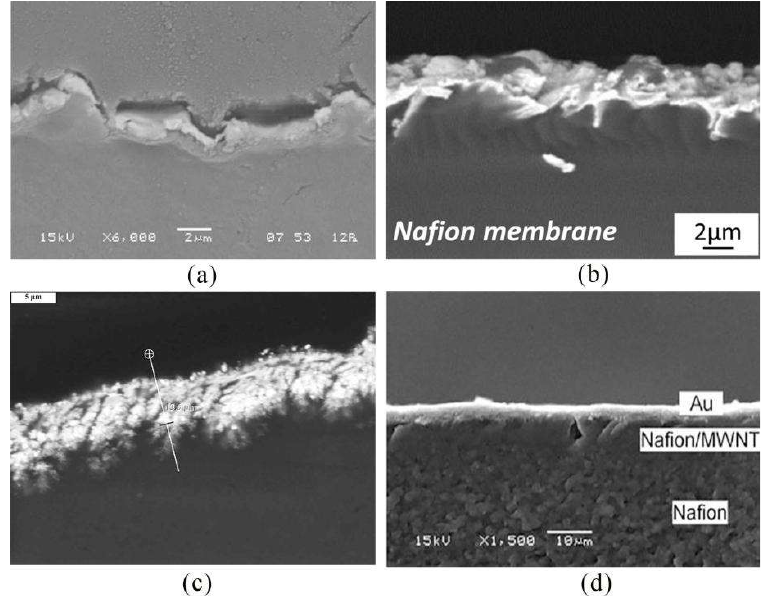
Figure 5. Chitosan actuator based on hot pressing method [59]. ( a ) Schematic diagram of the assembly and bimorph configuration of an actuator. ( b ) Typical SEM cross-sectional image of a bimorph configured actuator.